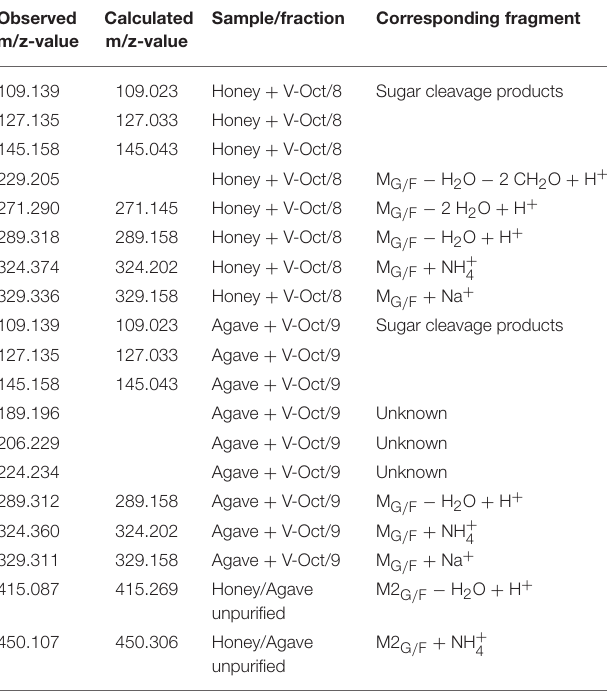
TABLE 2 | Rf-values of all visible spots and their corresponding possible compounds. Sugar source